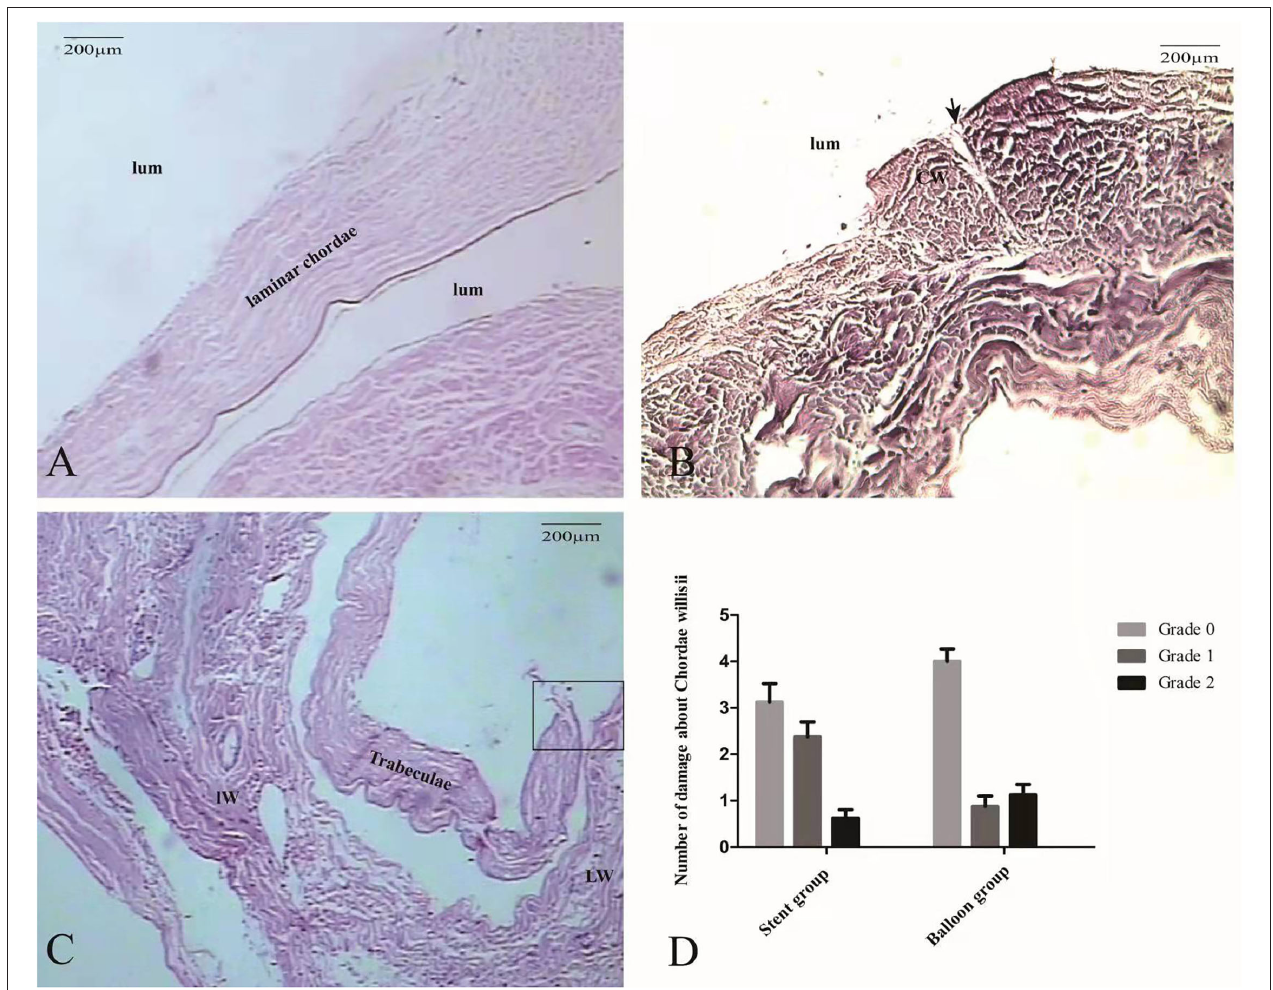
FIGURE 5 | The morphological characteristics of intraoperative damage to the CW observed by microscopy. At Grade 0, the CW predominantly consists of collagen tissue and endothelial cells (HE, × 100) (A) . In a Grade 1 case, histopathological coronal sections showed the damage of endothelial cells (black arrow) and small area collagen fiber exposure (B) . In a Grade 2 case, a large area collagen fiber (square)was exposed completely (HE, × 100) (C) . Graphs show comparisons of the damage to the CW between the stent group and the balloon group (D)